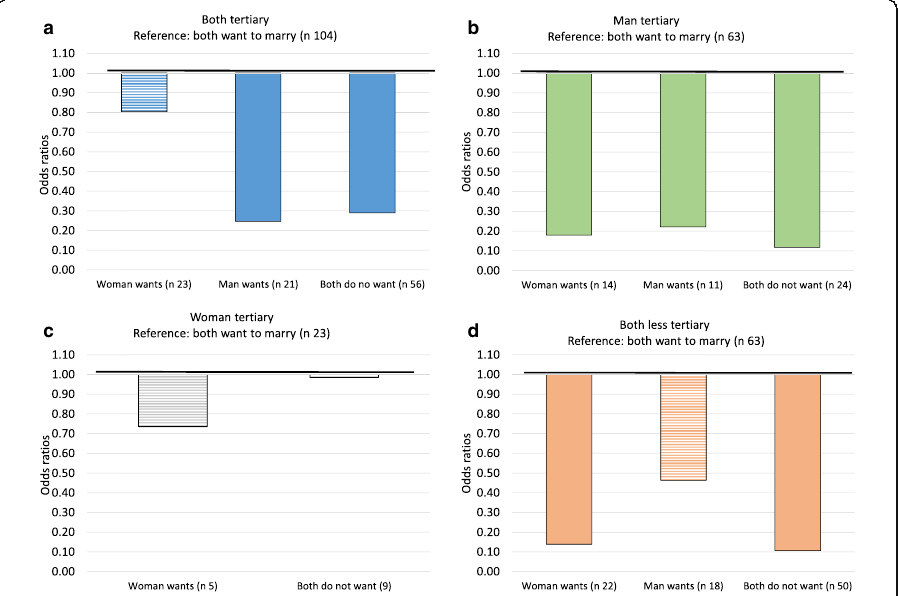
Fig. 2 a – d Odds of marriage by combination variable between marital intentions and education (the figures display separate models adjusted for woman ’ s age, couples ’ education level, parental status, union duration, and marital attitudes). The striped bars indicate statistically non-significant